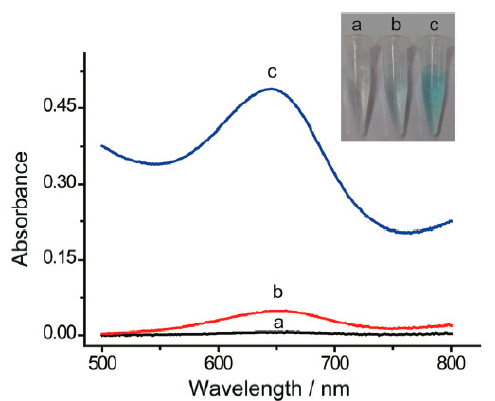
Figure 9. Absorption spectra and image (inset) of 500 µ M TMB in the presence of ( a ) 10 mM H 2 O 2 , ( b ) 10 mM H 2 O 2 and 5 µ g/mL − 1 Au nanoclusters, and ( c ) 10 mM H 2 O 2 , 5 µ g/mL − 1 Au nanoclusters and 250 µ M Pb 2+ . (Reprinted with permission from [98]. Copyright © 2017, Royal Society of Chemistry.).